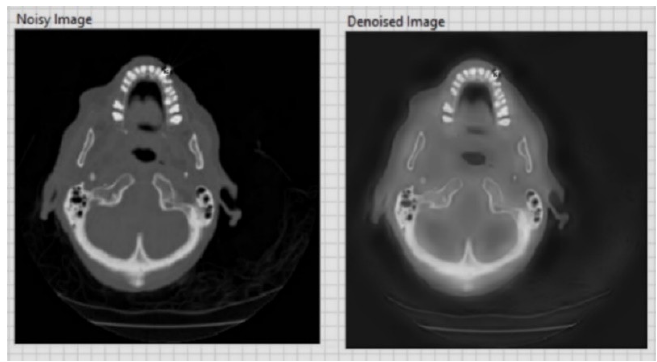
Figure 8. Noise reduction from a CT image, using Daubechies scale filter order 2 (db2) [76].